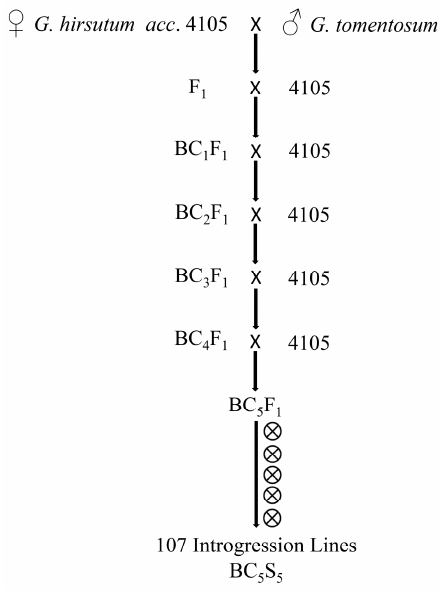
Figure 1. Strategy for development of 107 interspecific hybridization derived ILs used in the study. ⊗ means selfing. Table 1. Mean squares of various fiber quality and yield traits revealed by Analysis of Variance (ANOVA). Source of